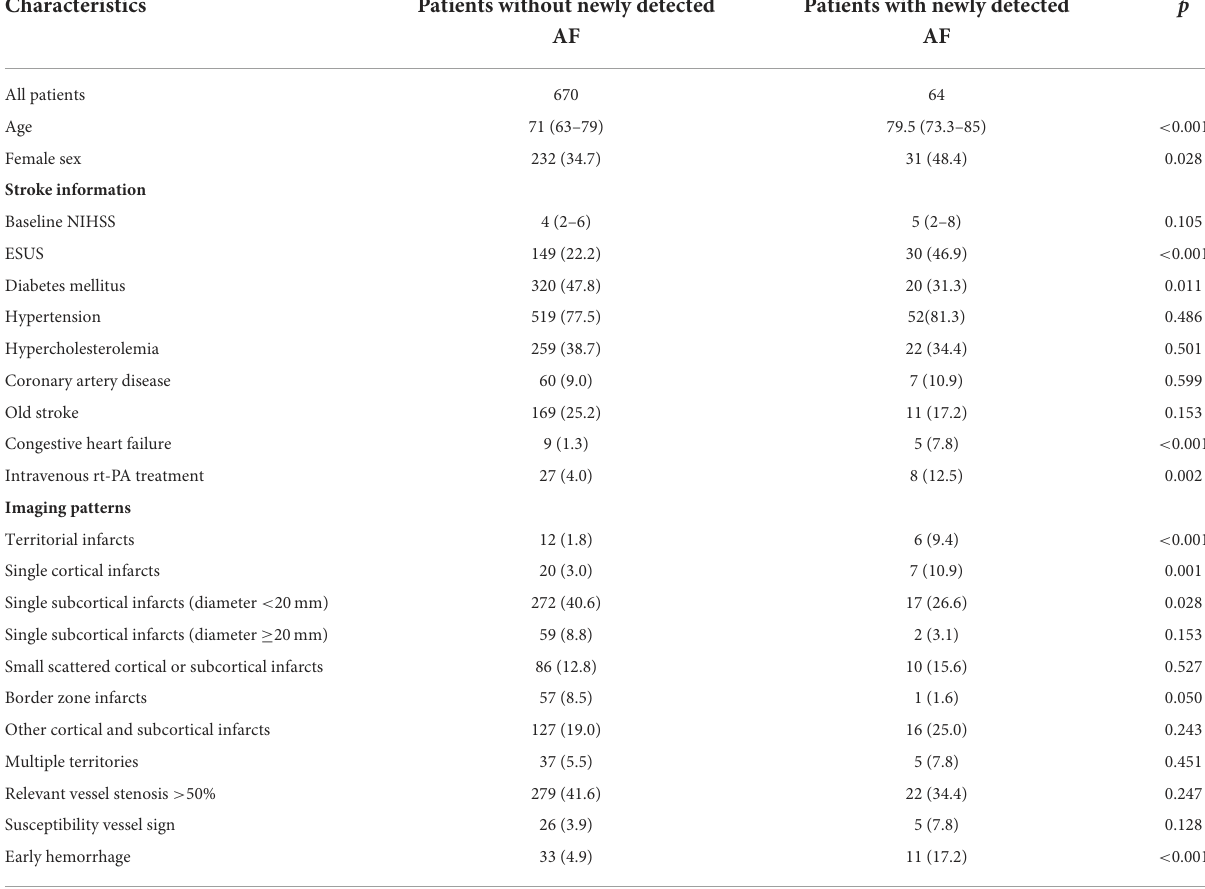
TABLE 1 Baseline characteristics, imaging findings and outcomes, and correlations with newly detected atrial fibrillation. Characteristics Patients without newly detected Patients with newly